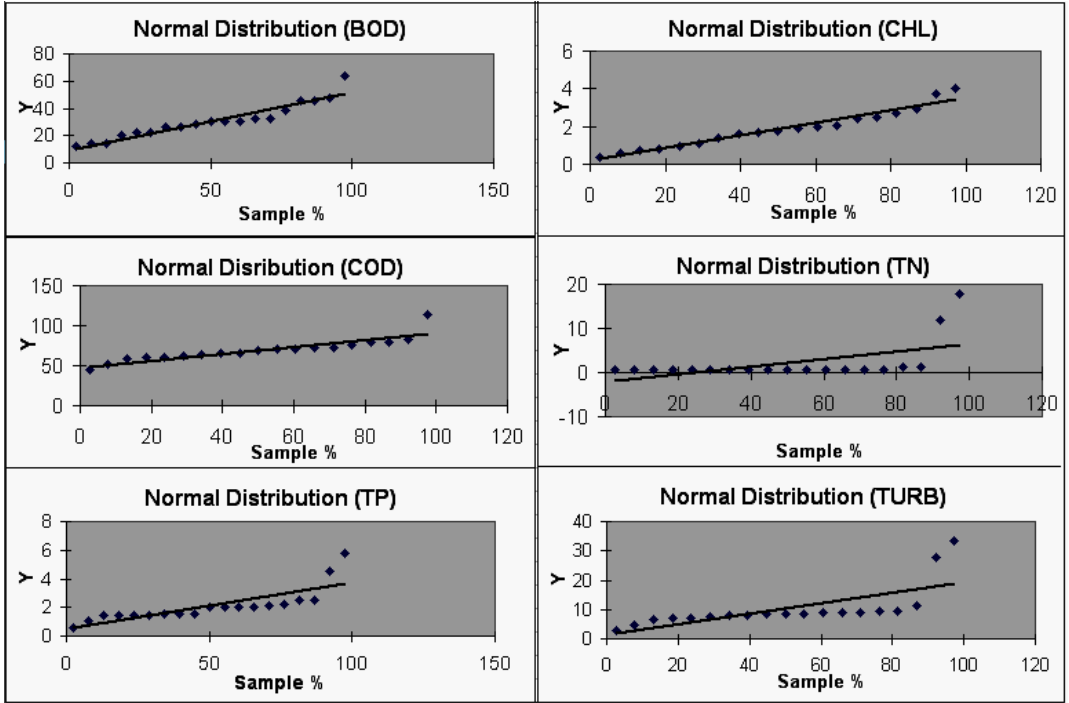
FIGURE 5 . Normal distribution vs. sample % plots for selected WQ